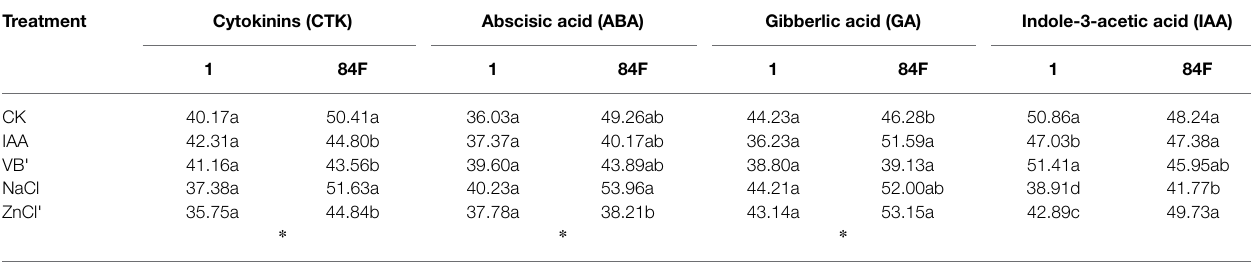
TABLE 2 | Percentage of hormone content in the culture filtrate in total content (%). Treatment Cytokinins